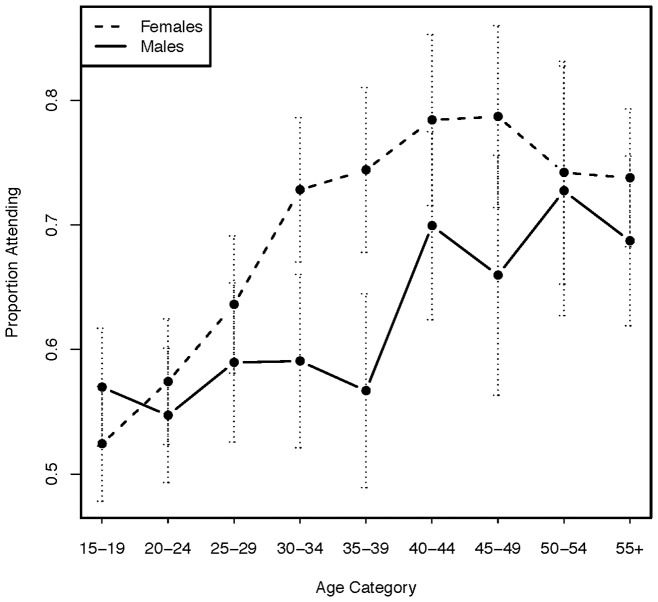
Proportion of residents attending the 2012 community health campaign (CHC) according to sex and age group among residents ≥15 years old.The dashed vertical lines indicate 95% confidence intervals.